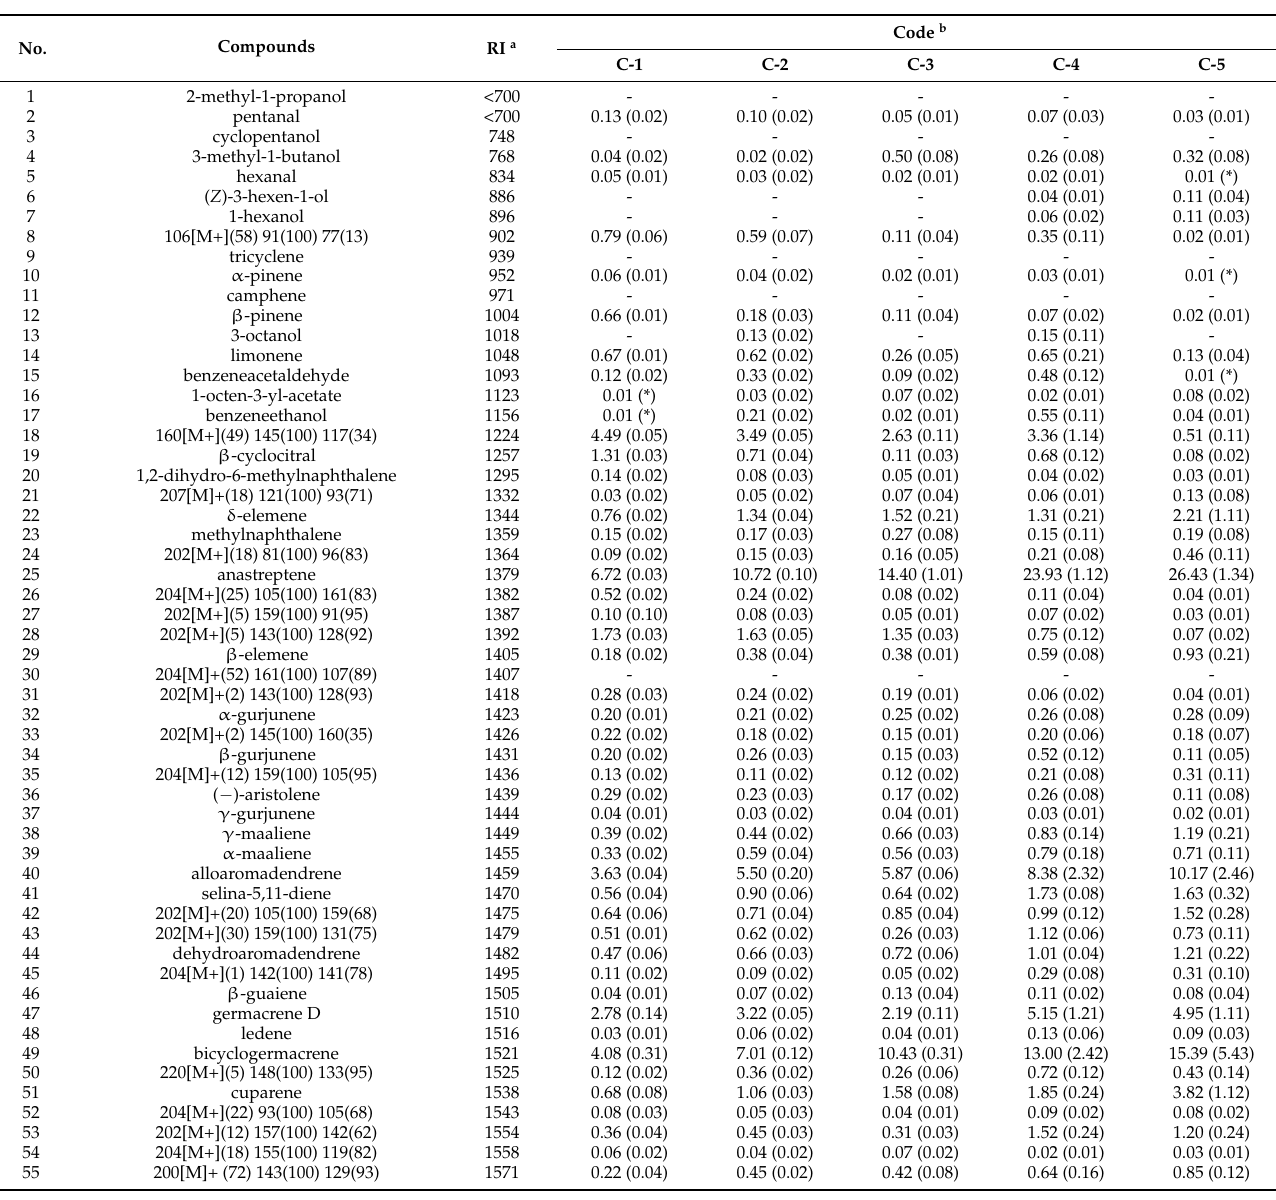
Table 2. Volatile compounds detected in the samples